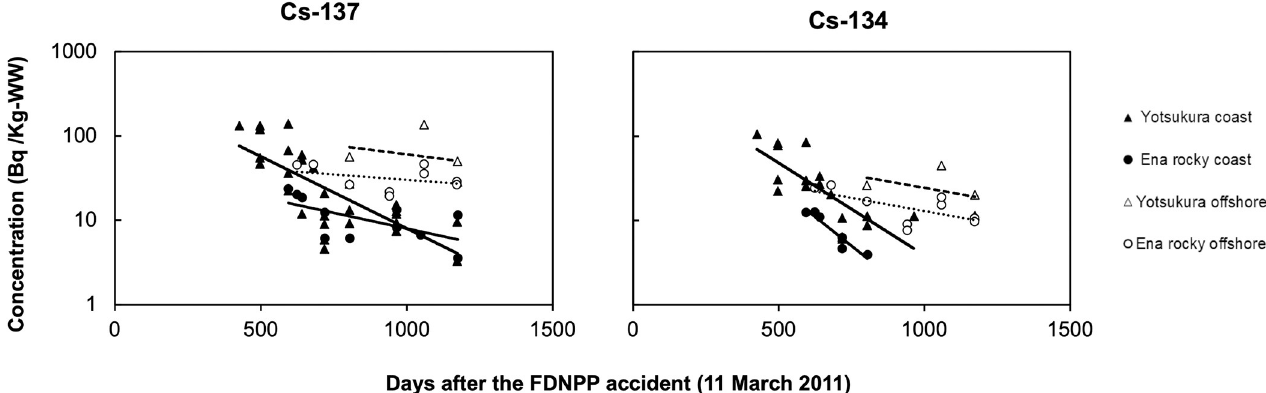
Fig 3. Spatial and temporal changes in the 137 Cs and 134 Cs activity concentrations in sea urchin gonads collected from four fishing grounds in Fukushima Prefecture after the FDNPP accident. Solid and dashed lines represent statistically significant and insignificant regression slopes, respectively. Different trend lines indicate different sampling stations for 137 Cs (—Yotsukura coast,—Ena rocky coast,—Yotsukura offshore, and — � Ena rocky offshore) and 134 Cs (—Yotsukura coast,—Ena rocky coast,—Yotsukura offshore, and — � Ena rocky offshore), respectively. Data below the detection limit and dry weight (DW) basis are excluded.